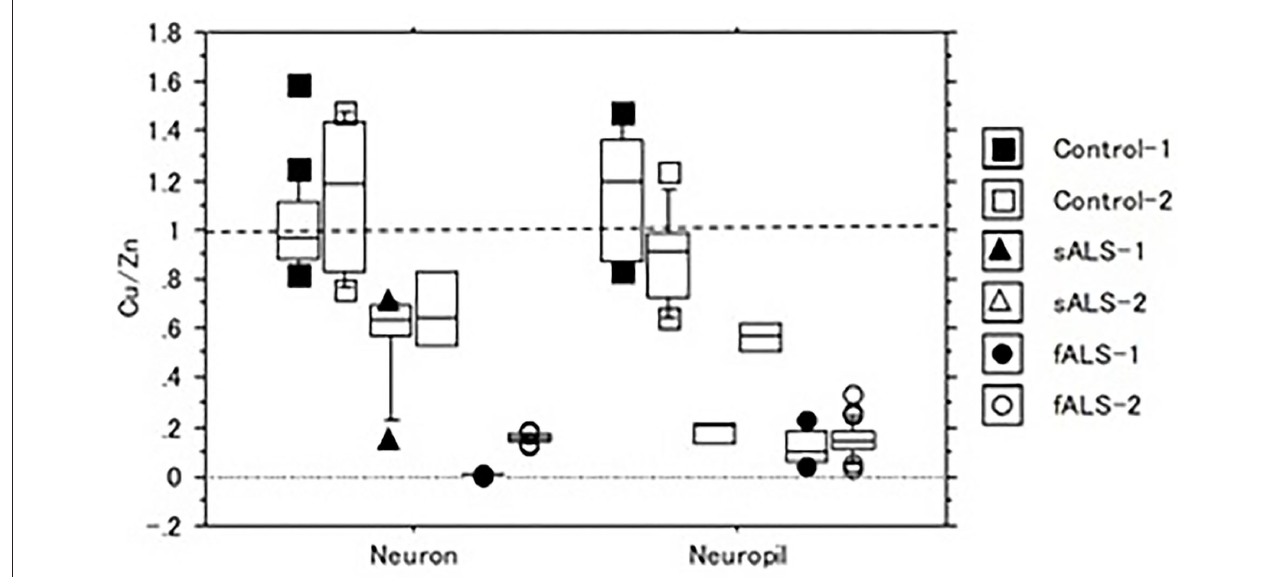
FIGURE 5 | The Cu/Zn ratio of neuron and neuropil in lumbar spinal cord tissues of sALS, fALS and control cases.